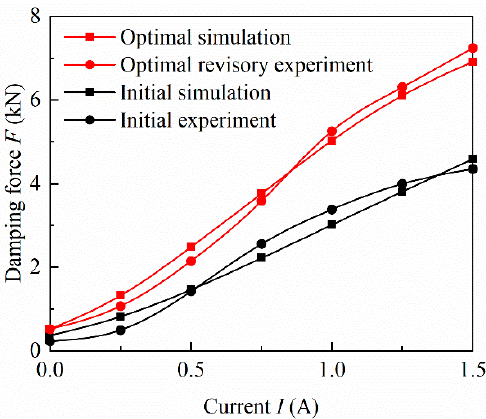
Figure 23. Comparison of damping forces of the initial and optimal MR dampers.